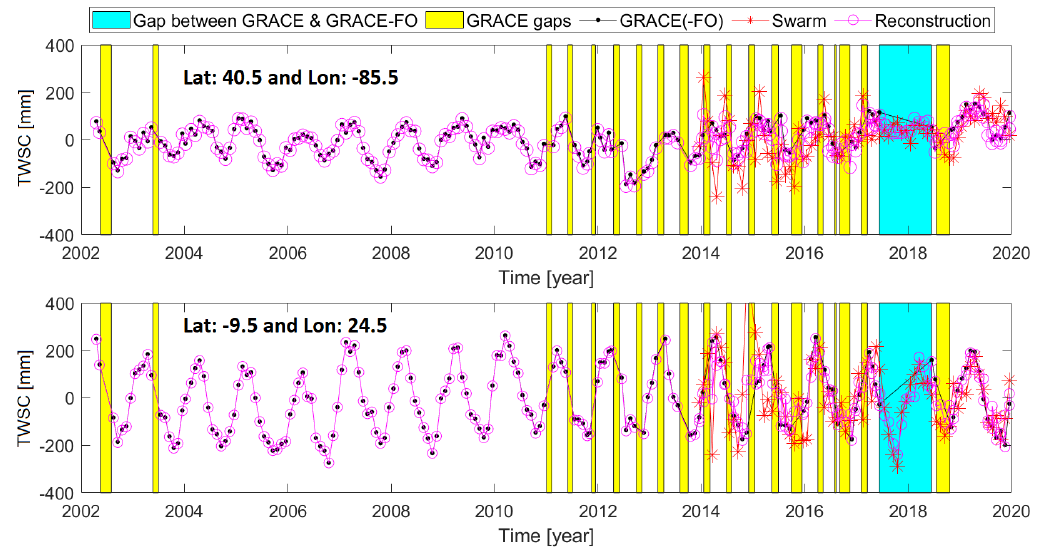
Figure A2. A comparison of TWSC estimations for two arbitrary points in the USA ( top ) and South Africa ( bottom